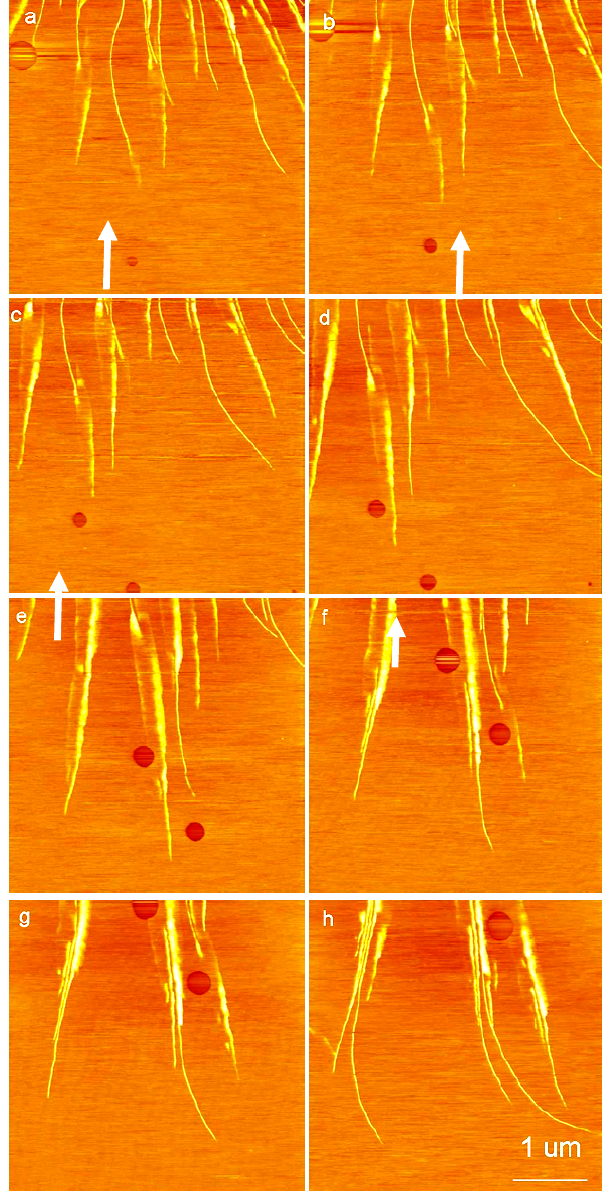
Figure 10. Real-time AFM phase images showing the lamellar twisting process and the consecutive right-handed macro screw dislocations caused by lamellar twisting in poly( R -3-hydroxybutyrate- co -17 mol% R -3-hydroxyhexanoate) crystallized at 85 °C. The images in ( b – h ) correspond to elapsed times of 17, 25, 68, 93, 119, 161, and 212 min, respectively, with respect to the first image ( a ). Reprinted with permission from Ref. [49]. Copyright (2007) Elsevier, Ltd.